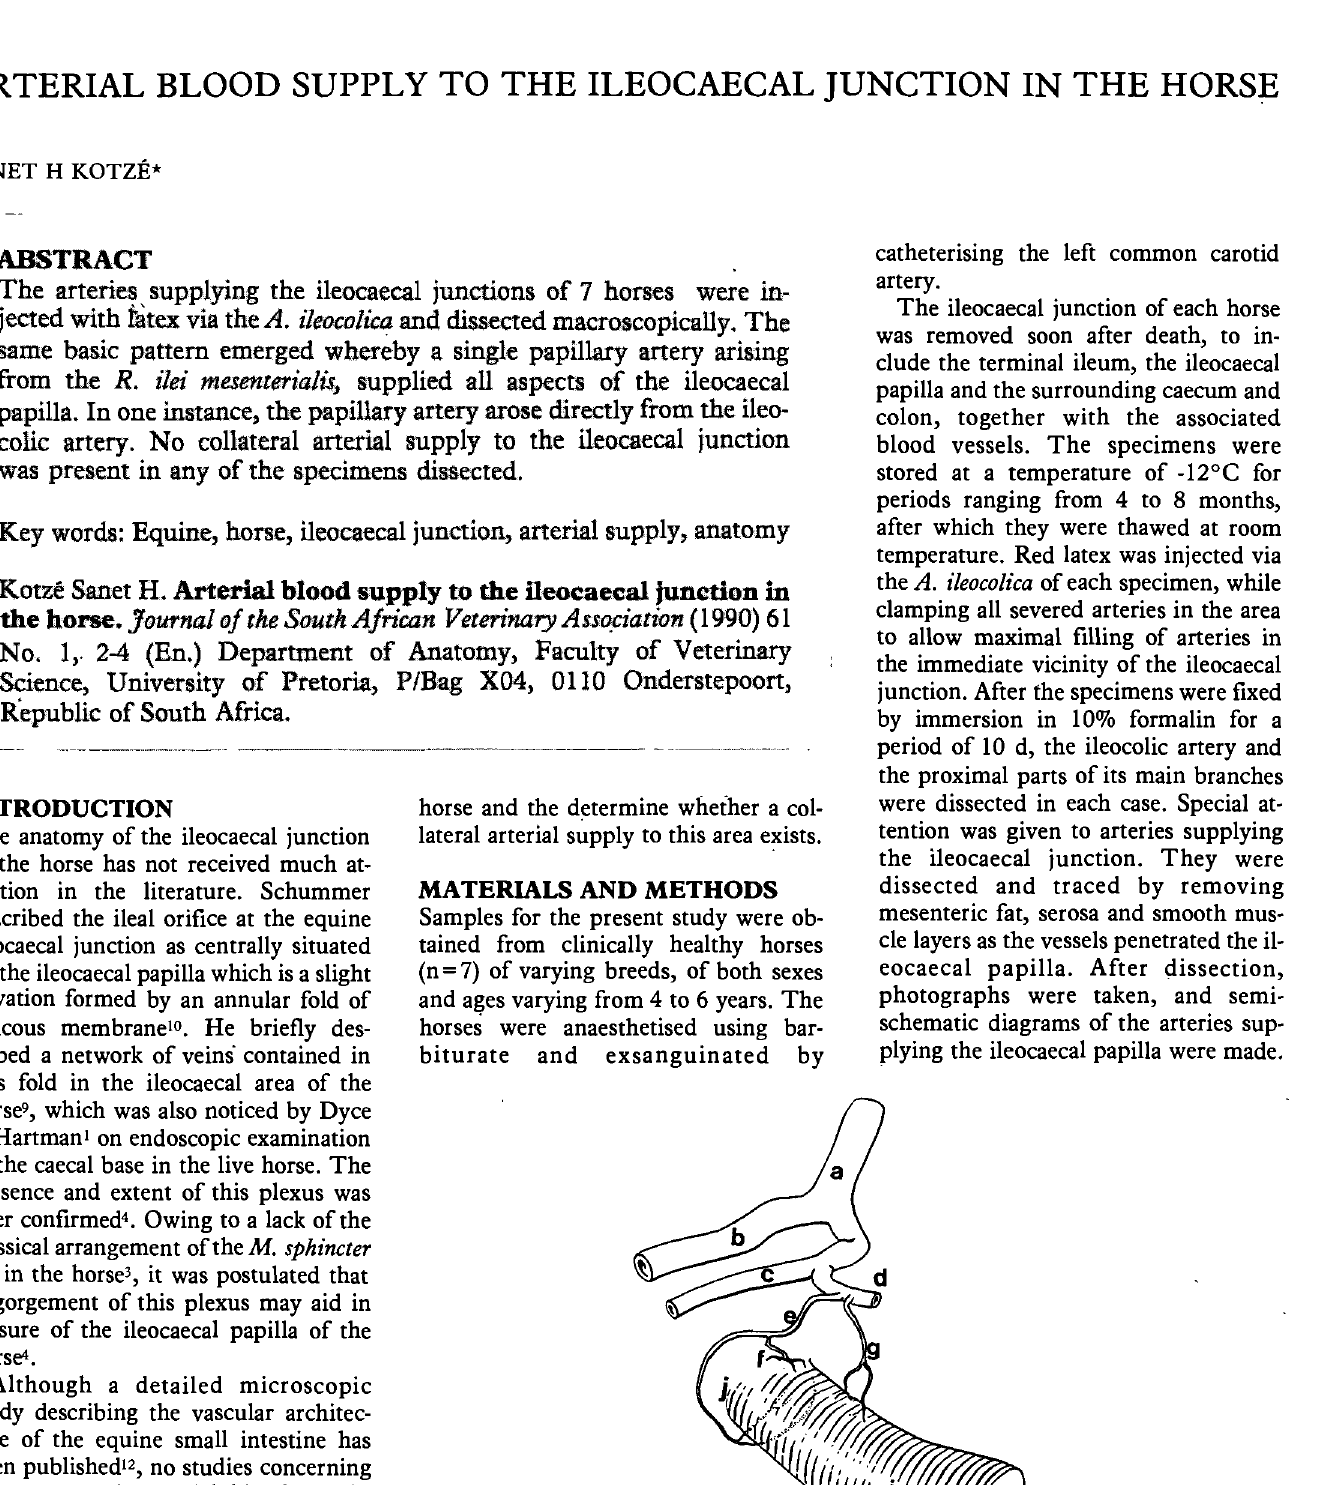
Fig. 1: A semi-schematic diagram of the Ueocaecal junction and its associated blood ·vessels as seen from the serosal